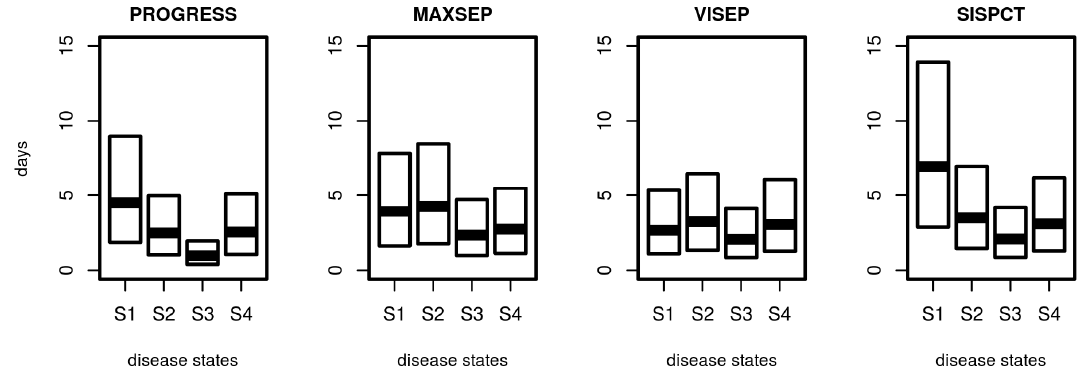
Figure 7. Distribution of sojourn times for disease states. For SepNet studies, we used the transition matrix obtained from fitting the first 15 days. Shown are the median and the 25% and 75% quartile of calculated sojourn times.